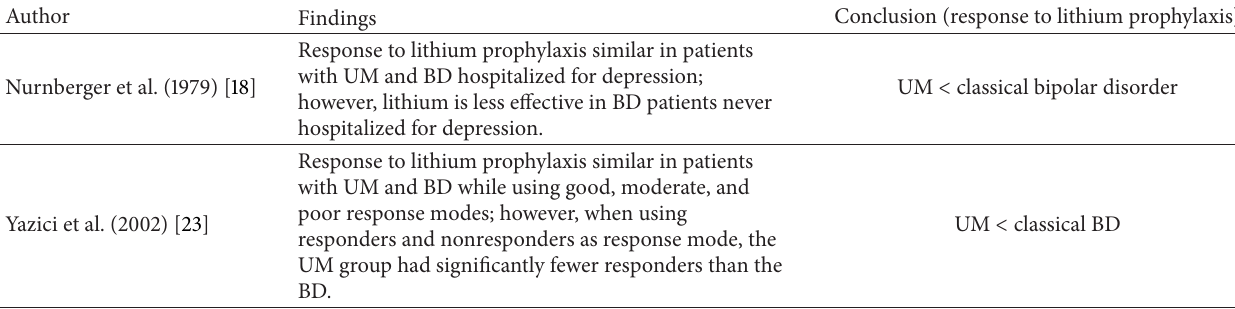
Table 4: Studies on UM assessing response to lithium